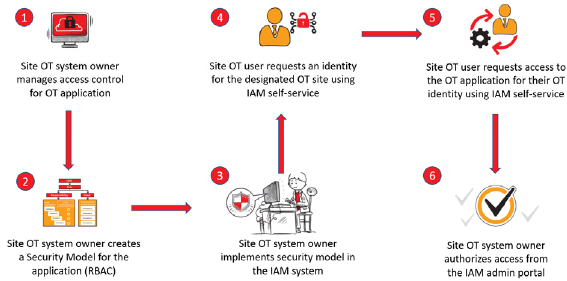
Figure 9 . Identity & Access Management for OT applications